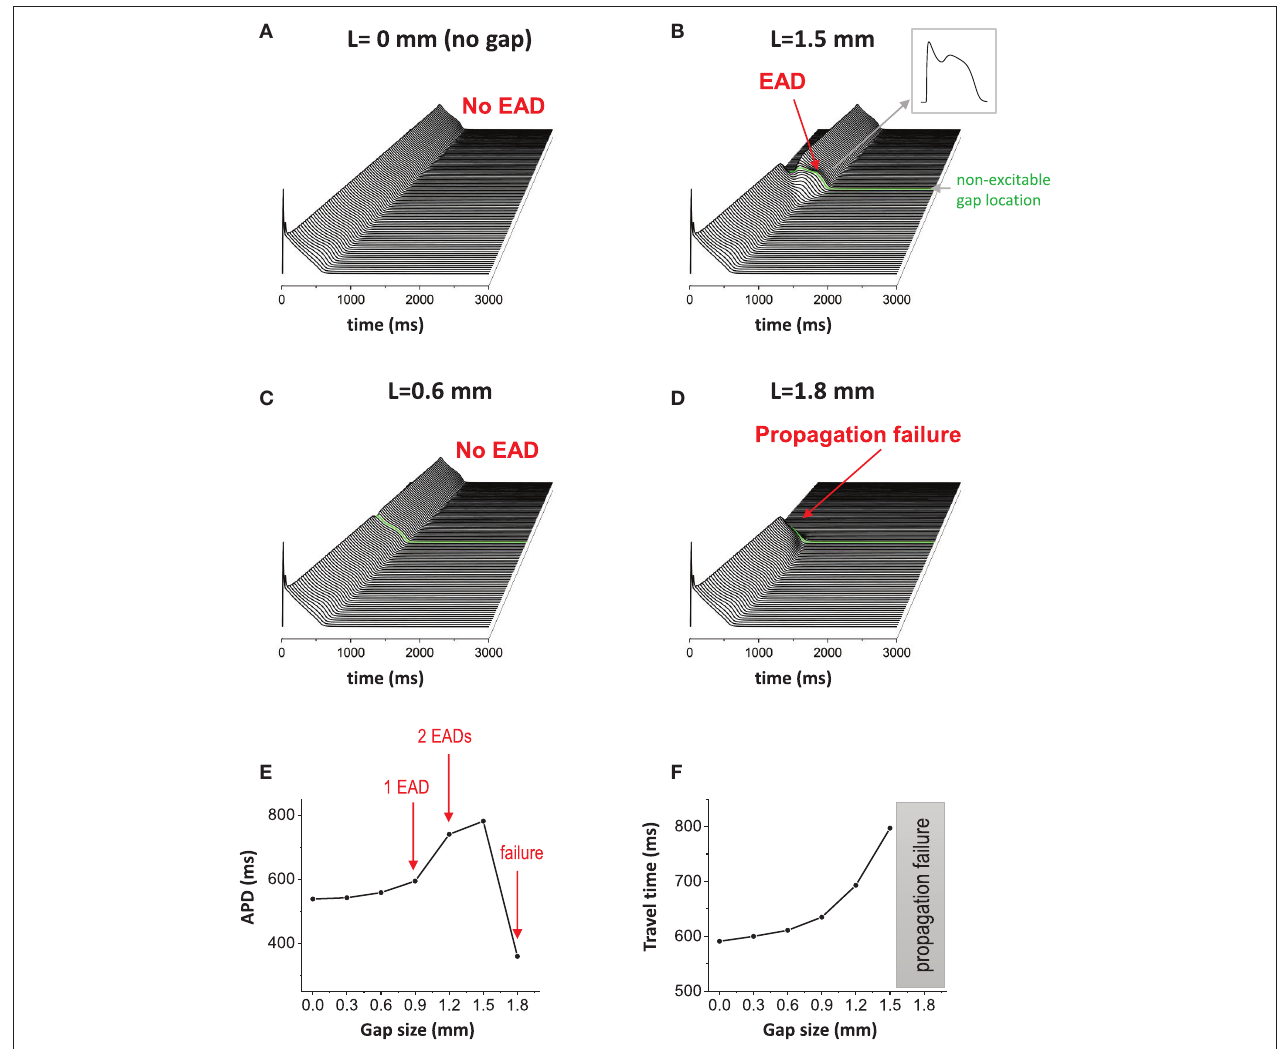
FIGURE 2 | Non-excitable gap causes EADs. (A) Without non-excitable gap, the action potential wave propagates without causing EADs in 1D tissue. Space-time plot. (B) When non-excitable gap is inserted, EADs occurred around the non-excitable gap region. The maximum APD is 781ms. The gap size is 1.5mm. (C) If the gap size is too small (0.6mm), no EADs occurred. (D) If the gap size is too large (1.8mm), propagation failed at the gap region. (E) APD vs. the gap size. (F) The travel time of action potential wave vs. gap